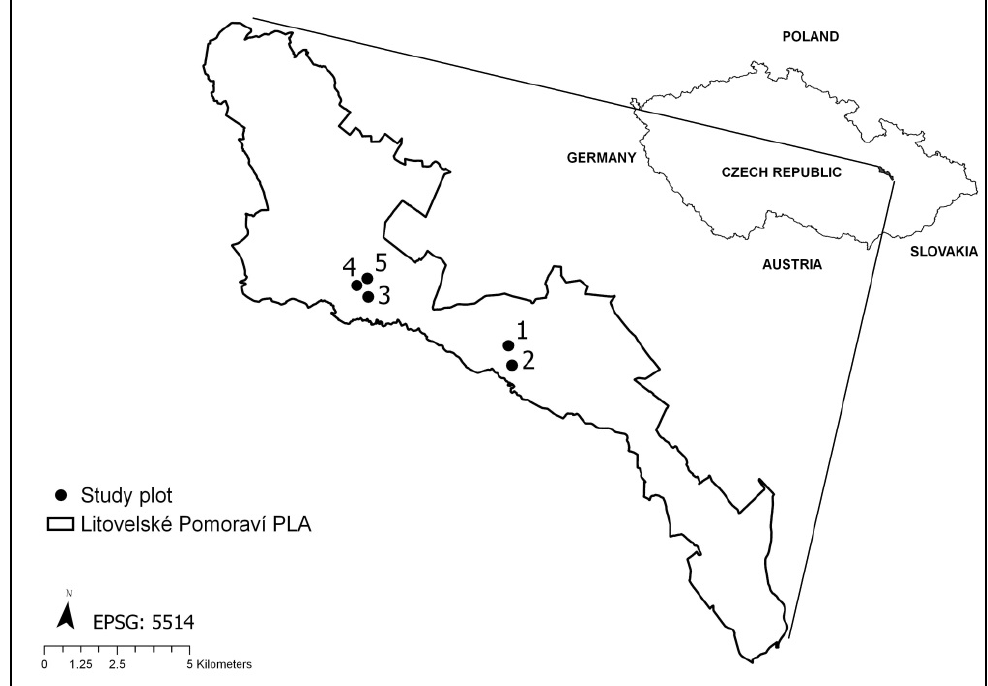
Figure 1. Study area and location of study plots 1–5.